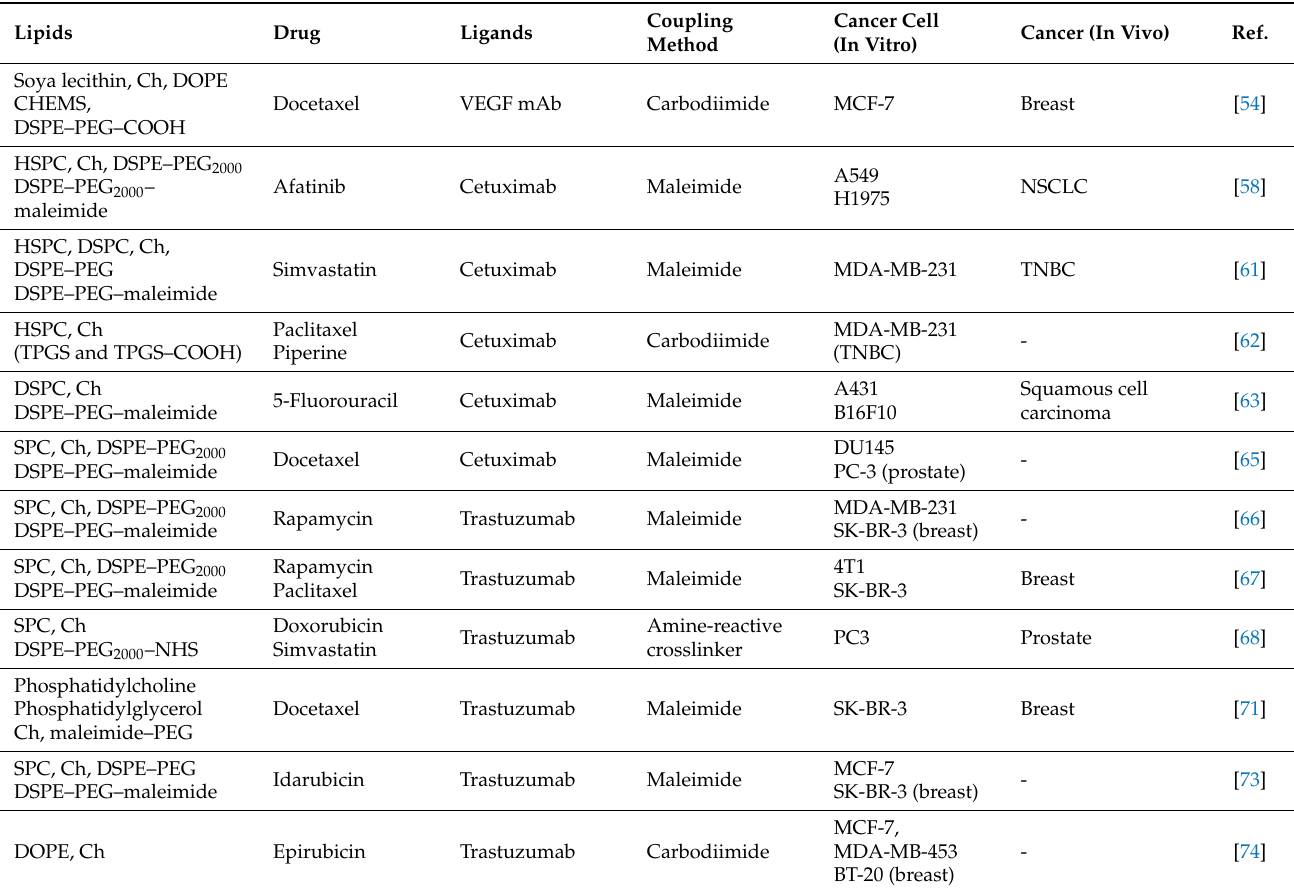
Table 3. Antibody-functionalized liposomes for anticancer drug